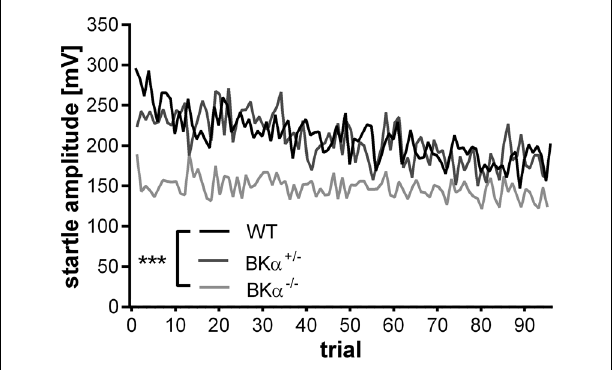
FIGURE 2 |Average startle response amplitudes of 100 trials. Average startle response amplitudes of BK α − / − , BK α + / − , andWT mice.WT mice show a decline in response amplitude, whereas knock-out animals show no decline, with heterozygous animals intermediate. 18WT (10 males/8 females), 17 BK α + / − (10/7), and 19 BK α − / − mice (9/10) were tested. *** p <